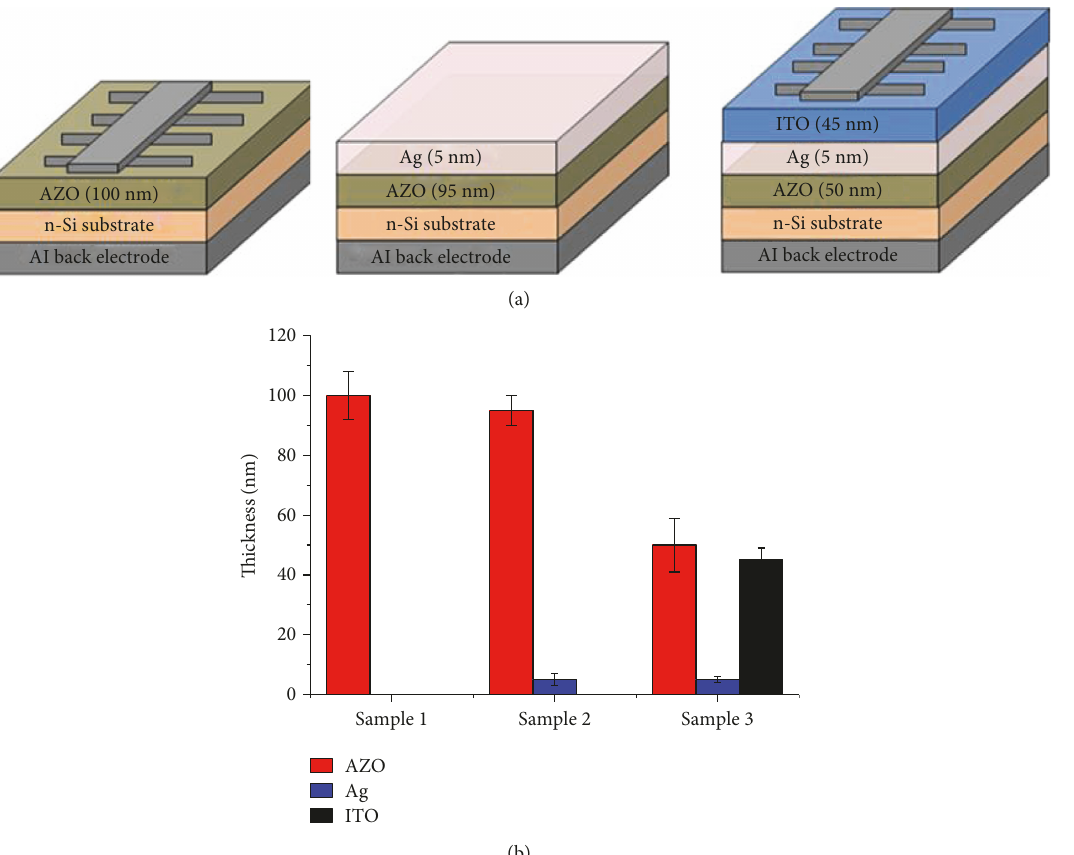
Figure 1: Schematic representation of the samples: (a) AZO/n-Si represented as S1, Ag/AZO/n-Si represented as S2, and ITO/Ag/AZO/n-Si represented as S3.